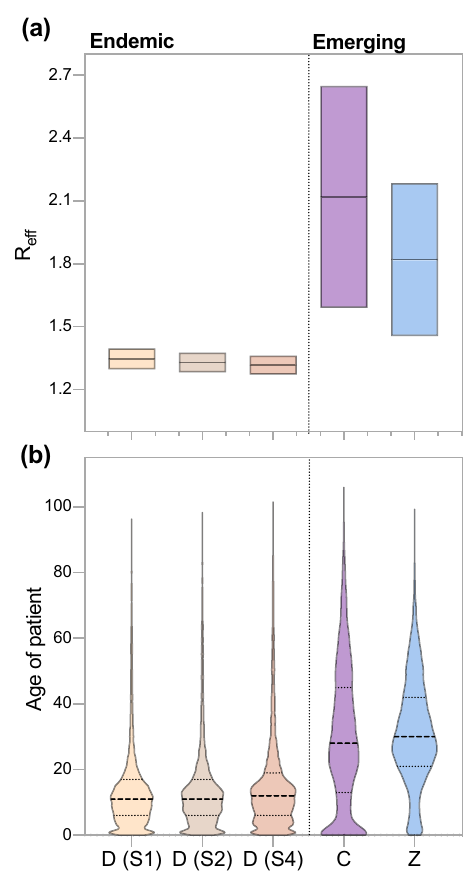
Fig. 3 The size of the susceptible population was larger for emerging diseases than dengue. a The effective reproduction number ( R eff ) of chikungunya and Zika far exceeded that of dengue. R eff was calculated using the growth rate of each outbreak 87 and estimates of the incubation period and serial interval of each disease (Supplementary Table 2). b The median age of reported cases during emerging disease outbreaks signi fi cantly exceeded that of the three dengue outbreaks. The median age group of the national population is 20 – 25 as calculated from population data reported in the 2010 census. Horizontal lines (dotted) indicate the median age for each group of